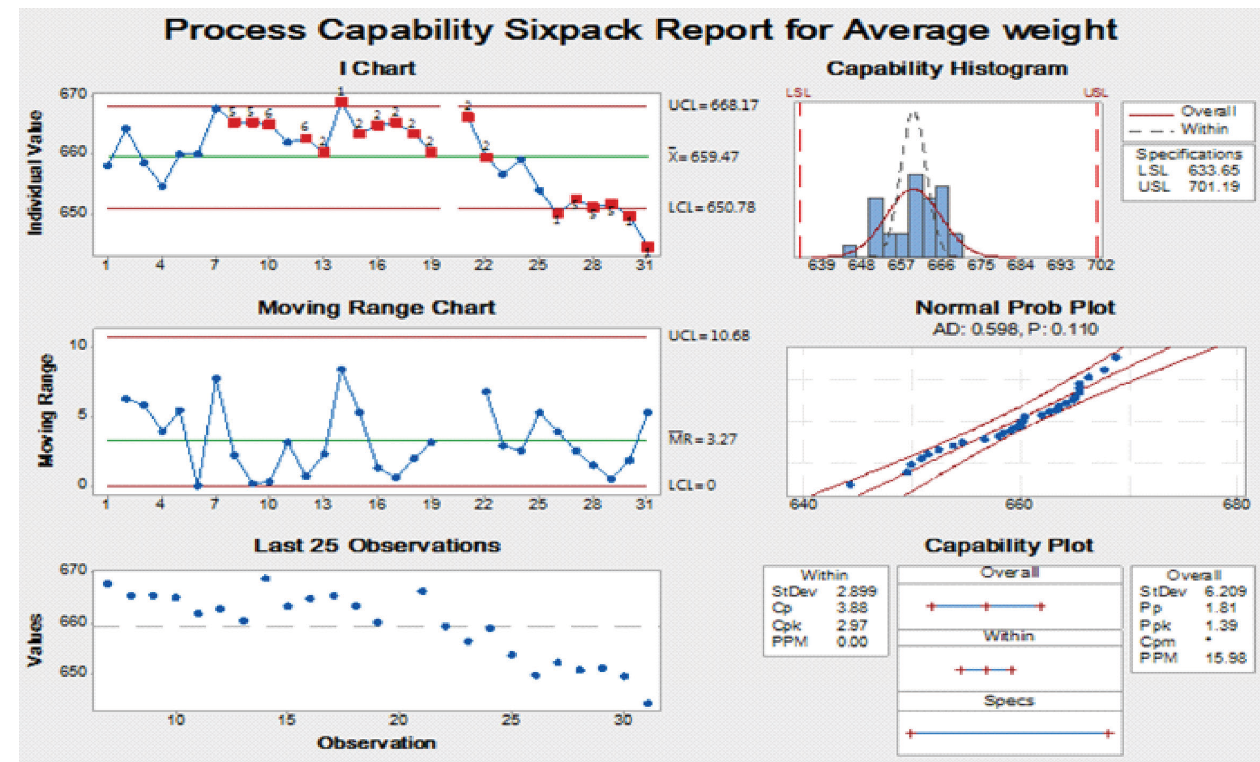
FIGURE 2 - Statistical control monitoring of average weight test showing out-of-control points as red dots.